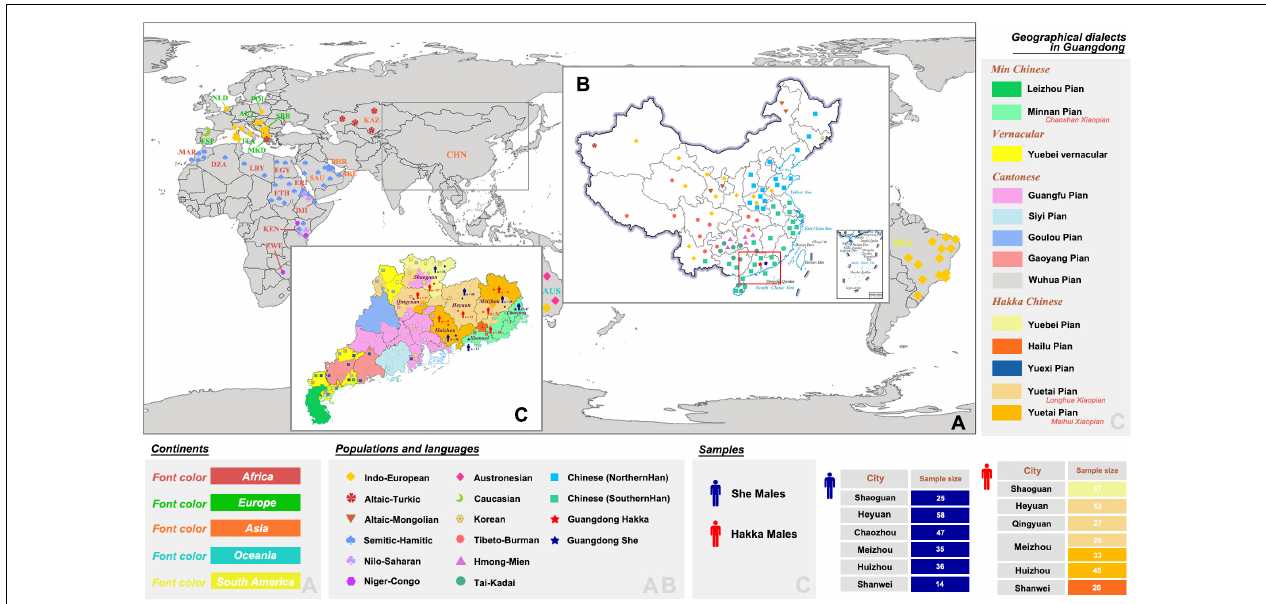
FIGURE 1 | Locations of population distributions and sampling information. (A,B) Geographic positions of Guangdong Hakka, Guangdong She, and 159 worldwide populations with nine language families (48,637 individuals in total). (C) Distributions of geographical dialects in Guangdong province and detailed sampling information of Guangdong Hakka and Guangdong She